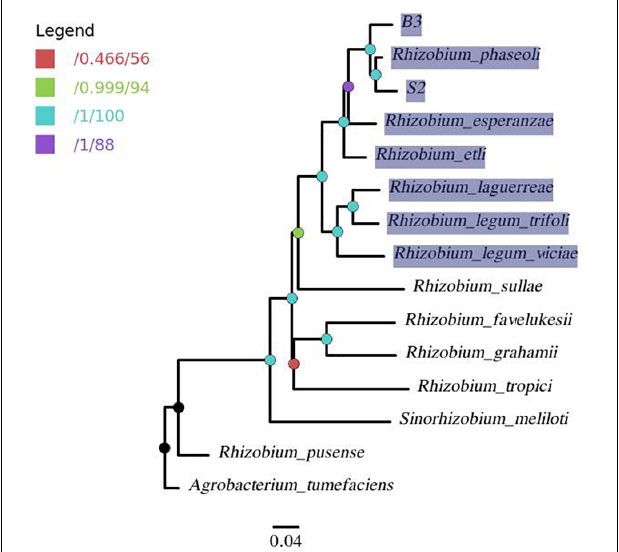
FIGURE 5 | A pangenome tree showing phylogenomic relation between isolates B3, S2, and 12 reference genomes with A. tumefaciens as outgroup. The nodes are colored per the legend in which the first value corresponds to approximate Bayes branch support values, and the second is the UFBoot support values. The node with less than 95% support (red node) was collapsed. The highlighted taxa represents common bean-nodulating